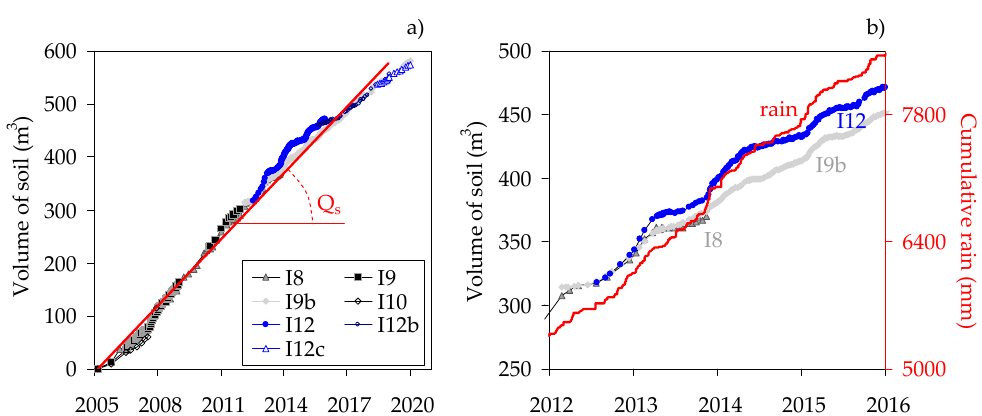
Figure 14. Vectors of average rates of horizontal displacements obtained from inclinometer, GPS, and PSInSAR data in the period May 2011–March 2014 and from topographic measurements carried out in 2010–2011 (a) ; zoom (b) and longitudinal section (c) of Varco d’Izzo earthflow accumulation.